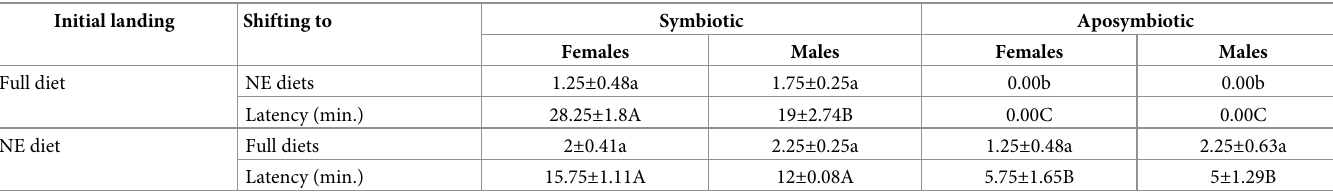
Means of shifting flies and shifting latency followed by different letters (small and capital letters, respectively) within rows are statistically different after Tukey HSD Test at P =